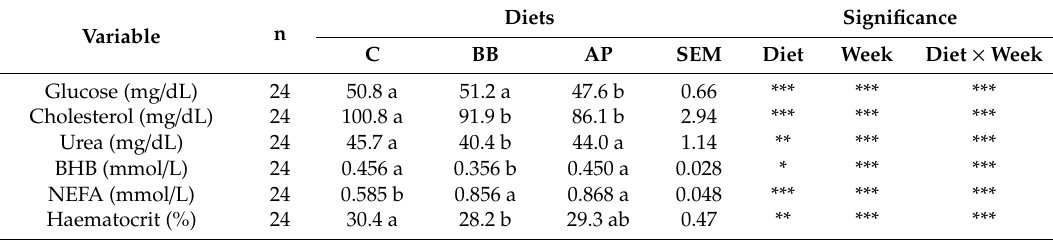
Table 7. Comparison of plasmatic profile according to the e ff ects considered from 7th to 27th lactation week.